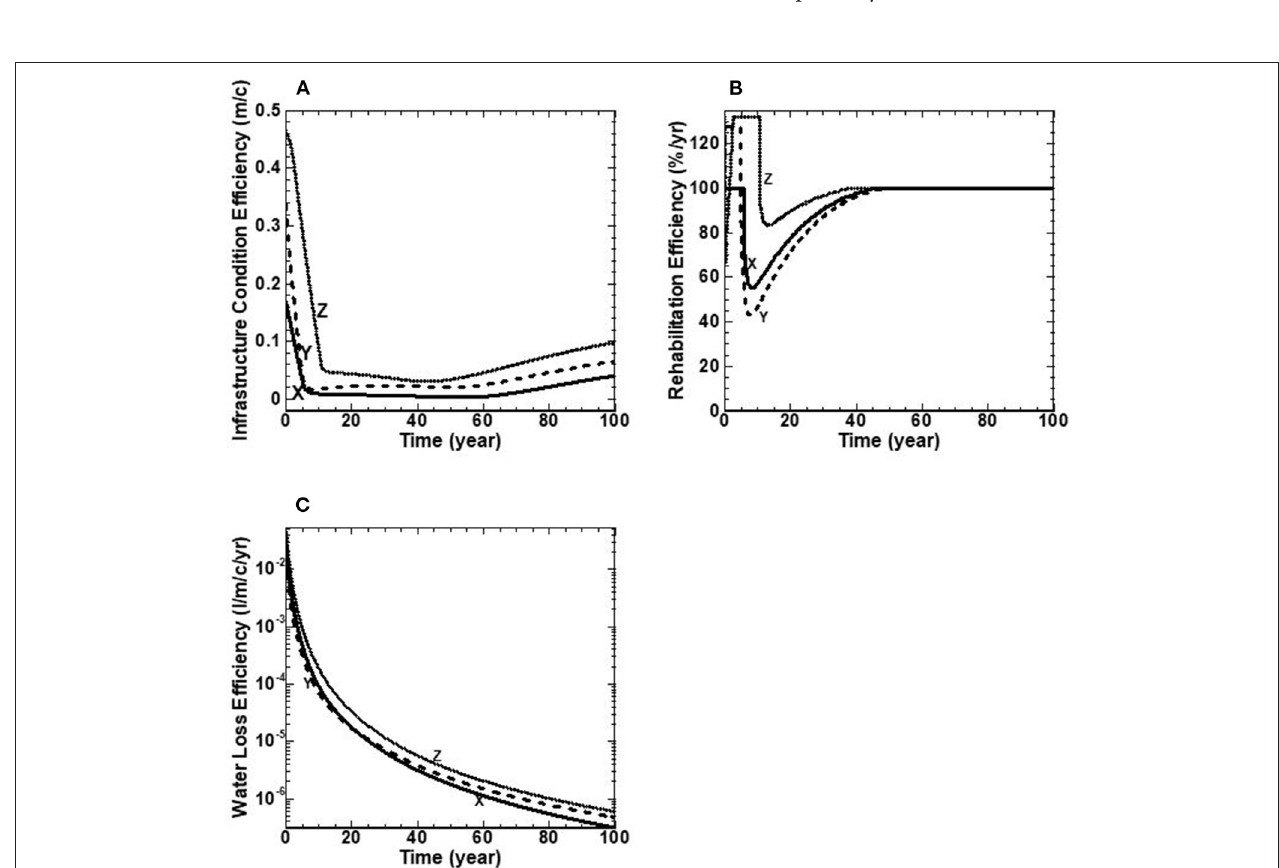
FIGURE 6 | (A–C) Water infrastructure performance indicators over a 100-year benchmarking period for utilities X, Y, and Z.